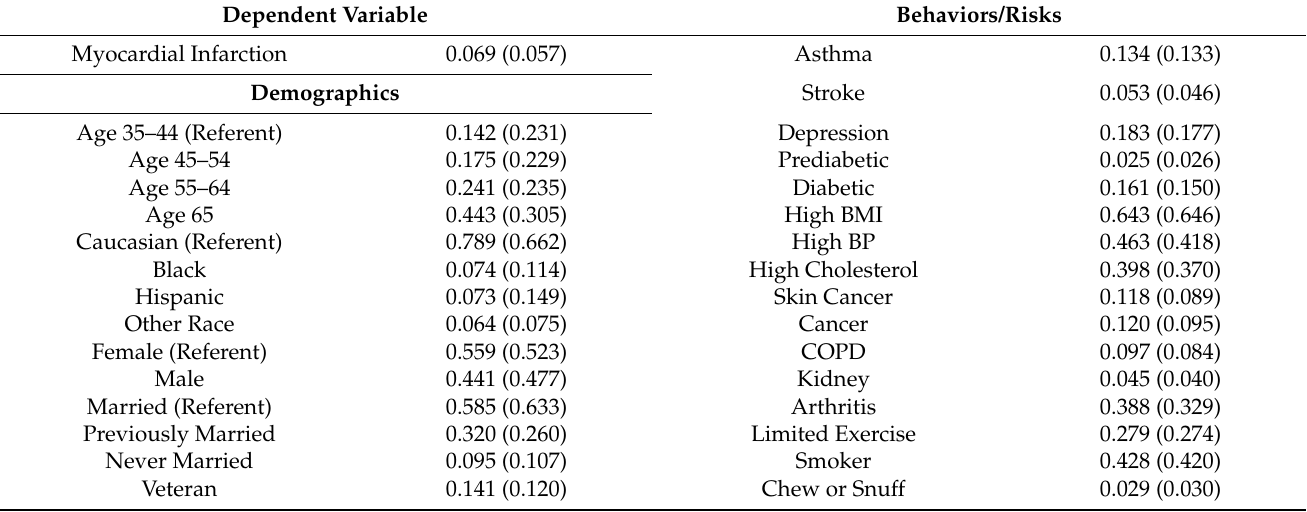
Table 2. Proportions by variable group and variable, unweighted